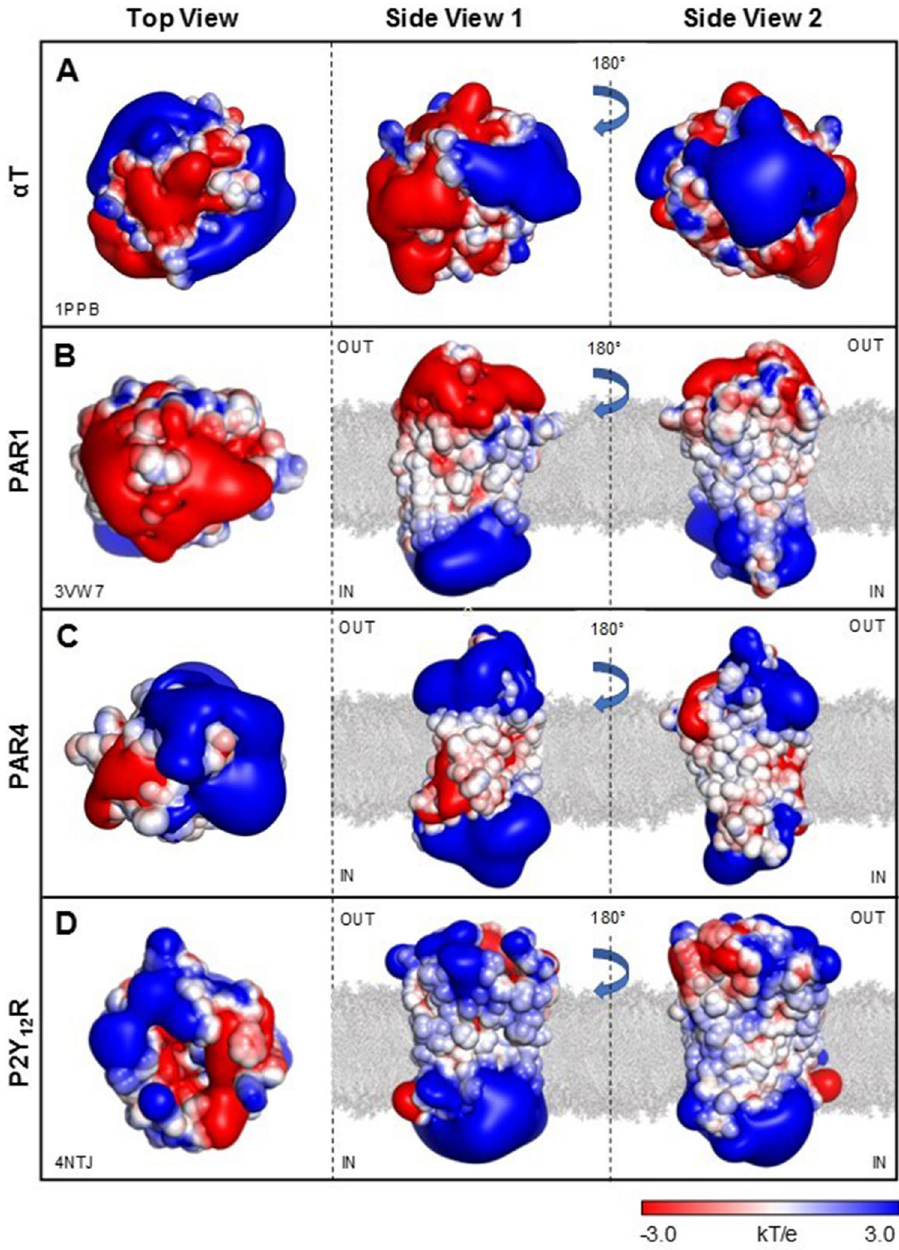
Figure 10. Surface electrostatic potential of αT ( A ), αT receptor PAR1 ( B ), and ADP receptor P2Y 12 R ( C ). Calculations were carried out using the APBS software on the deposited structures of αT (1 ppb), PAR1 (3vw7), P2Y 12 R (4ntj). PAR4 was modeled by homology on the PAR1 structure. Images were generated with PyMOL vs. 1.3 (DeLano Scientific, San Diego, CA, USA). The surface is coloured according to the electrostatic potential (blue, positive; red, negative) and expressed as kJ/(mol·q). Phospholipid double layer (grey) has been manually inserted. ( A ) αT displays an asymmetrical electrostatic potential, with a strongly negative active site (AS) region flanked by the two electropositive exosites (I and II). ( B ) The structure of PAR1, lacking the flexible exodomain A 22 -E 90 , displays a highly polarized charged distribution, with a strongly negative extracellular surface (OUT) and a positive intracellular region (IN). As expected, the transmembrane region in contact with the phospholipid apolar chains is essentially neutral. PAR1 contains a Na + -ion bound in the middle of the 7TM-helix bundle. The contribution of this ion was not taken into account during electrostatic calculations. ( C , D ) PAR4 and P2Y 12 R display a charge distribution similar to that of PAR1. However, contrary to PAR1, the extracellular region of P2Y 12 R and PAR4 is mainly electropositive with only some interspersed negative